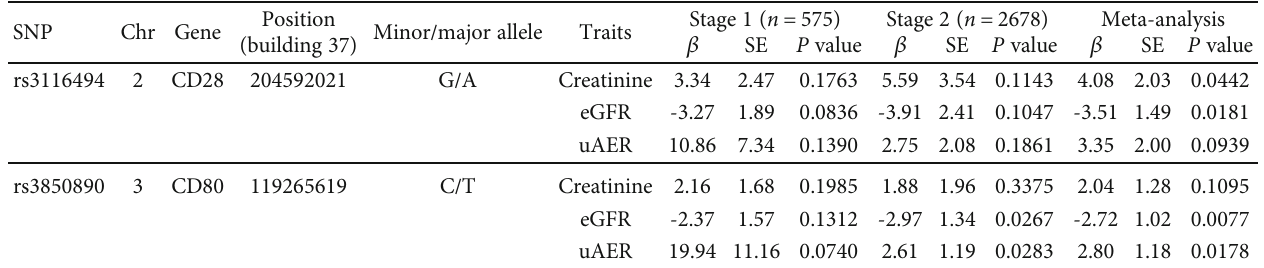
P values were calculated by multiple linear regression under an additive genetic model adjusted for age, gender, body mass index, duration of diabetes, and HbA1c; the e ff ect values were evaluated by minor allele. P < 0 : 05 was considered statistically signi fi cant. Chr: chromosome; eGFR: estimated glomerular fi ltration rate; uAER: urinary albumin excretion